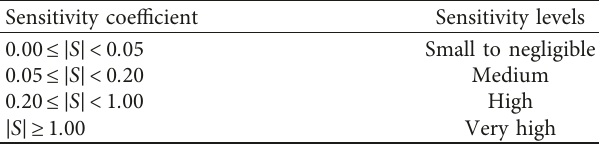
Table 4: Sensitivity level.